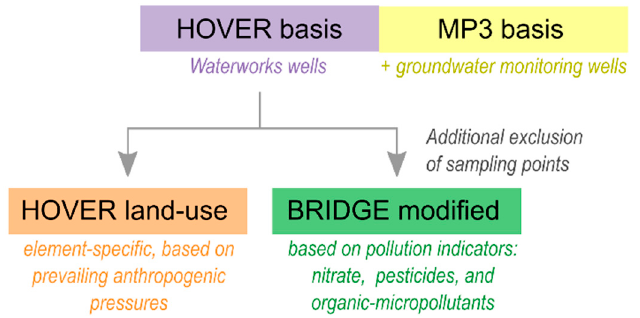
Figure 2. Compared methods and how they relate to each other, the basis method has two versions—from the HOVER project and from the third River Basin Management Plan (MP3). The dataset from HOVER basis is further used with HOVER land-use and BRIDGE modified methods.